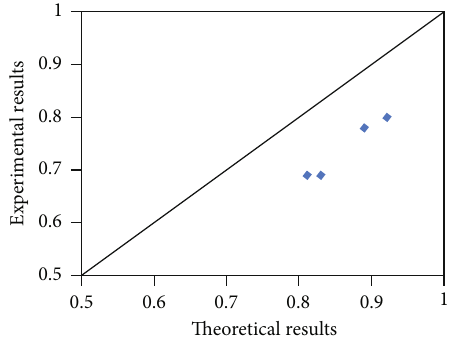
Figure 7: Comparison between theoretical solutions and experimental